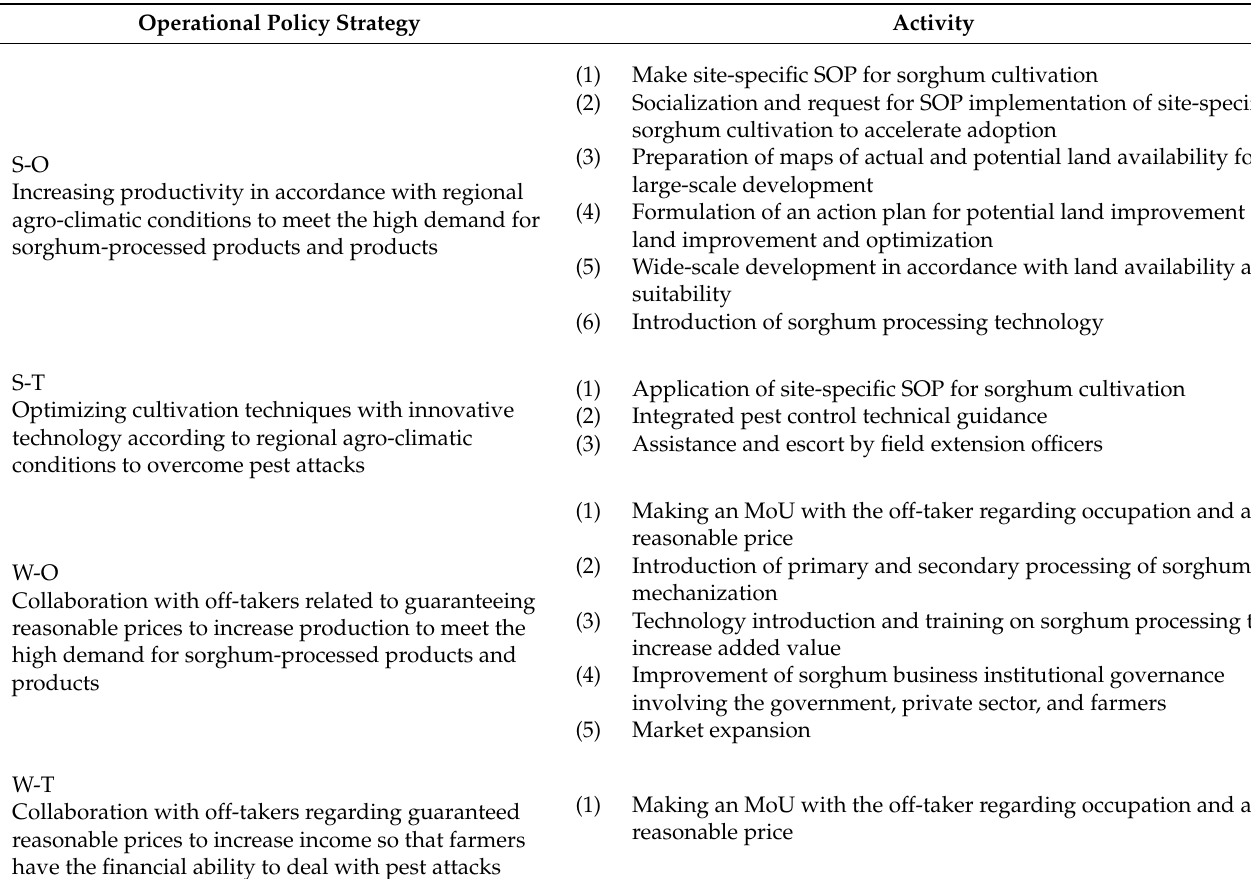
Table 9. Operational policy strategy for developing sorghum in Wonogiri Regency, Central